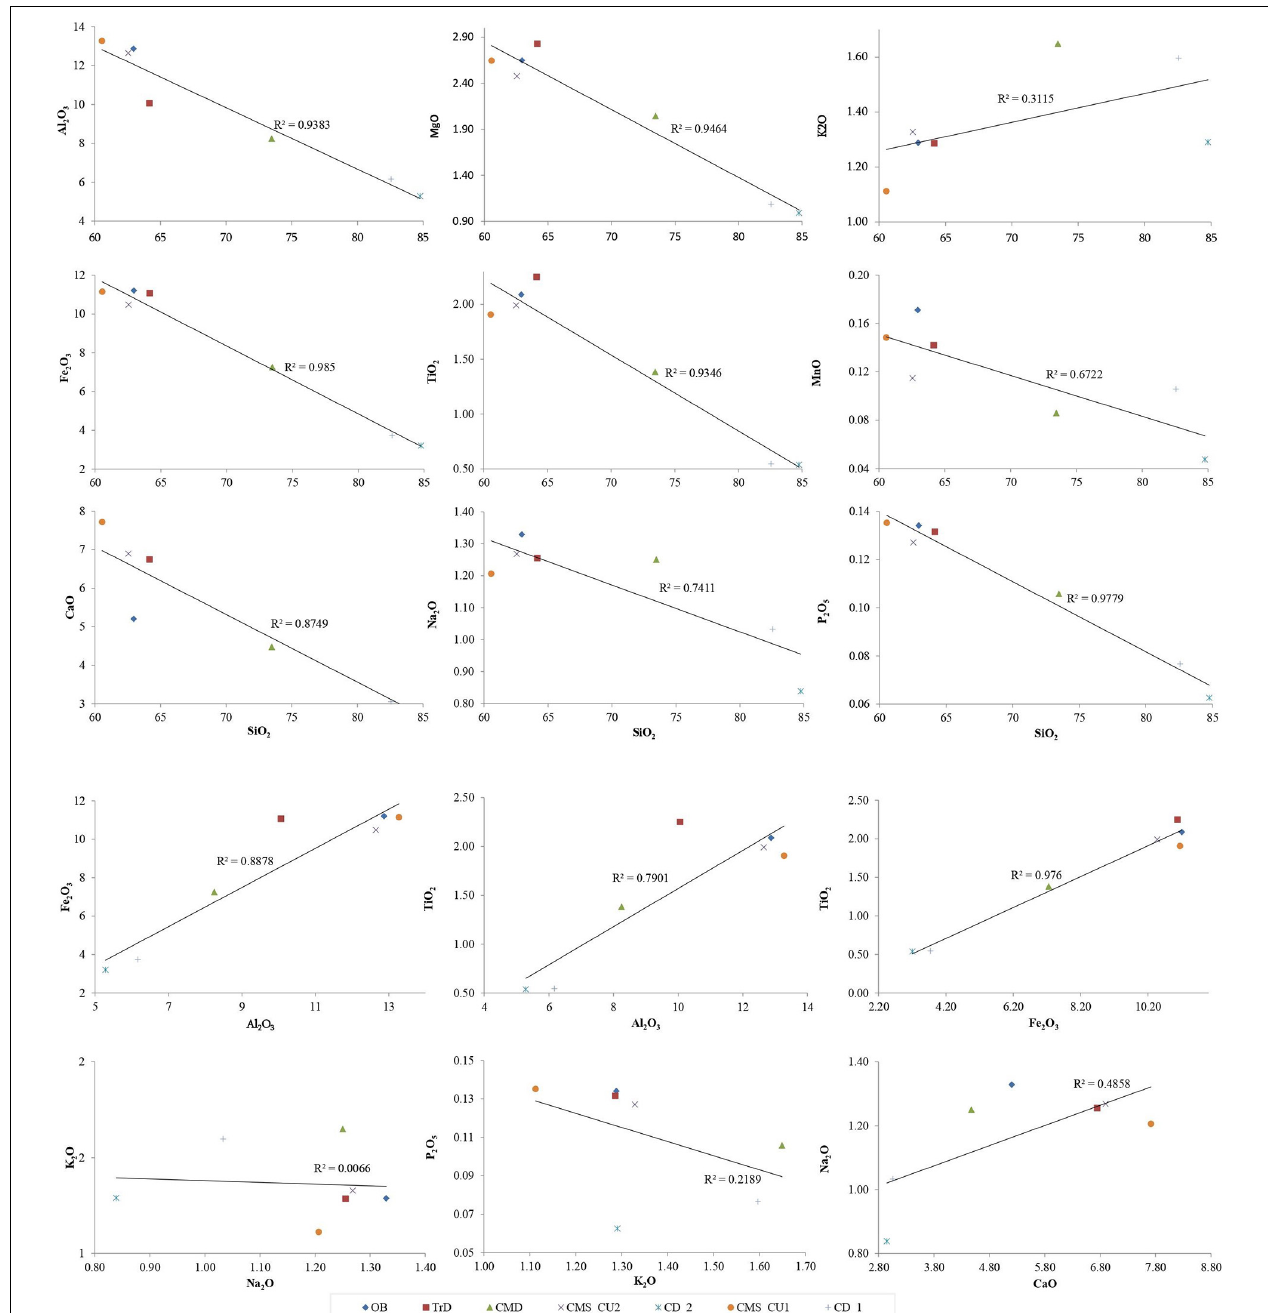
FIGURE 6 | Variation diagram of major oxides weight percentage against SiO 2 and other